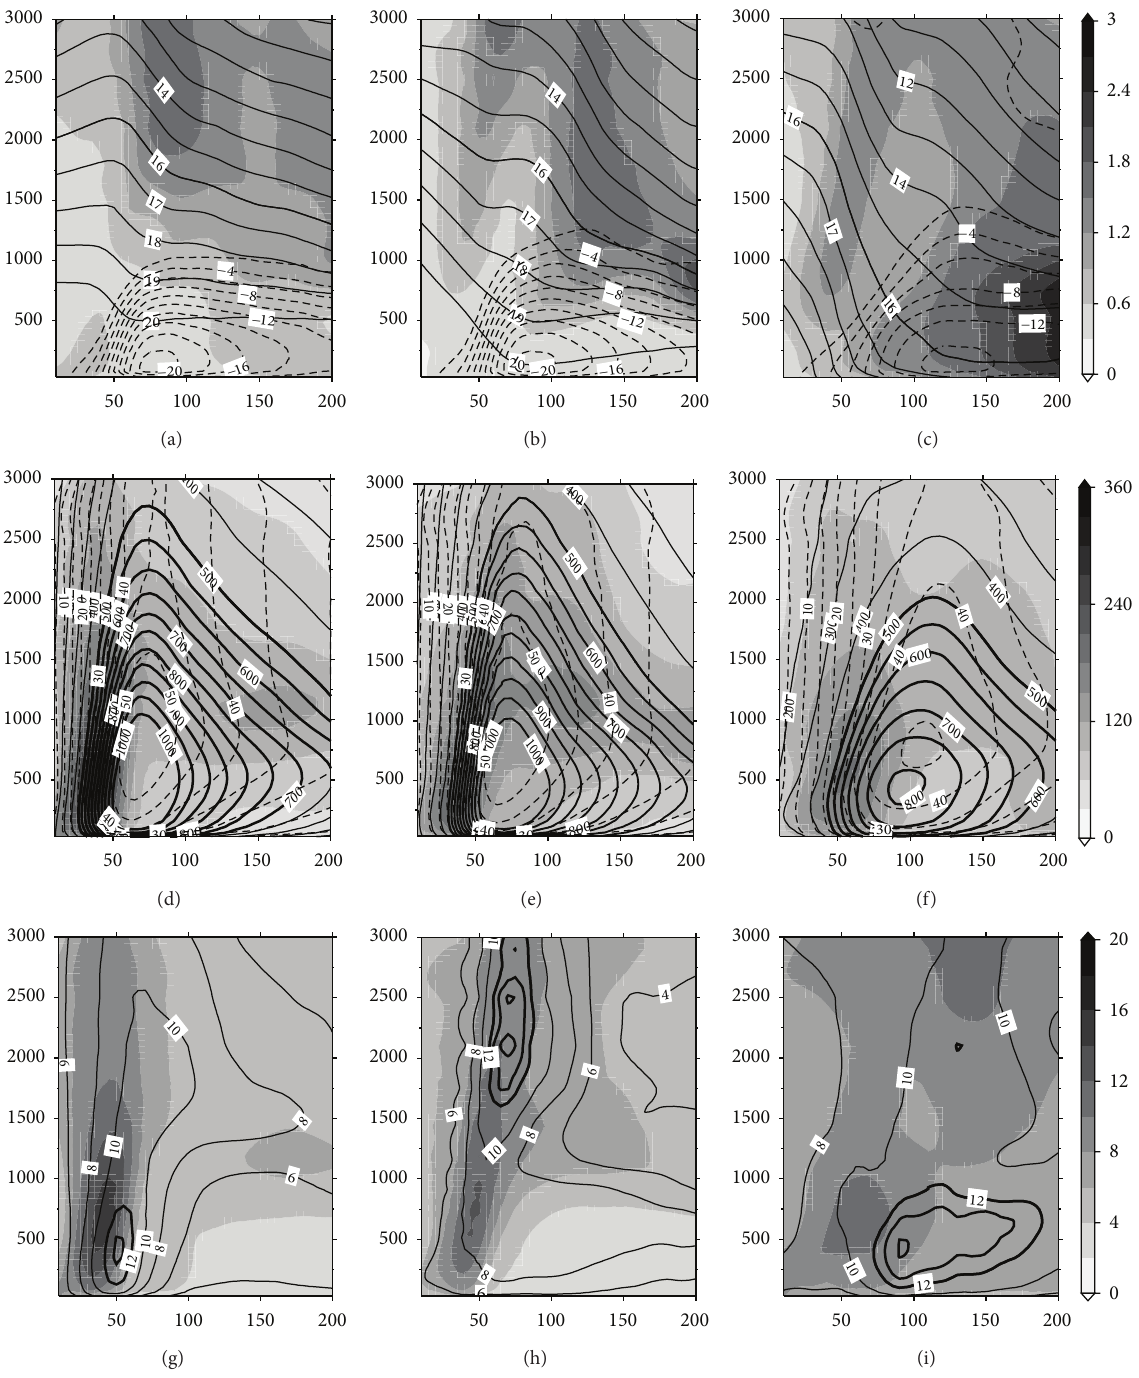
Figure 6: (a–c) Vertical profiles of the axisymmetric mean specific humidity (solid contours, contour interval 1gkg −1 ) of the 14 simulations, the standard deviations of all experiments, and radial flow (dashed contours, contour interval 2m s −1 , negative sign indicates inflow) at (a) 24 h, (b) 48h, and (c) 69 h. (d–f) Vertical profiles of the axisymmetric mean horizontal specific humidity flux (solid contours, contour interval 100 or 50 gm −2 s −1 ) of the 14 simulations, the standard deviations of all experiments (shading), and tangential flow (dashed contours, contour interval 5ms −1 , positive sign indicates cyclonic flow) at (d) 24 h, (e) 48h, and (f) 69h. (g–i) Vertical profiles of standard deviations of radial flow (contours) and of tangential flow (shading) among the 14 simulations at (g) 24h, (h) 48h, and (i) 69h. At values below 12 m s −1 (thin contours), the contour interval is 2 m s −1 , and at values above 12 m s −1 (thick contours), it is 1 m s −1 . The unit of the vertical axis is